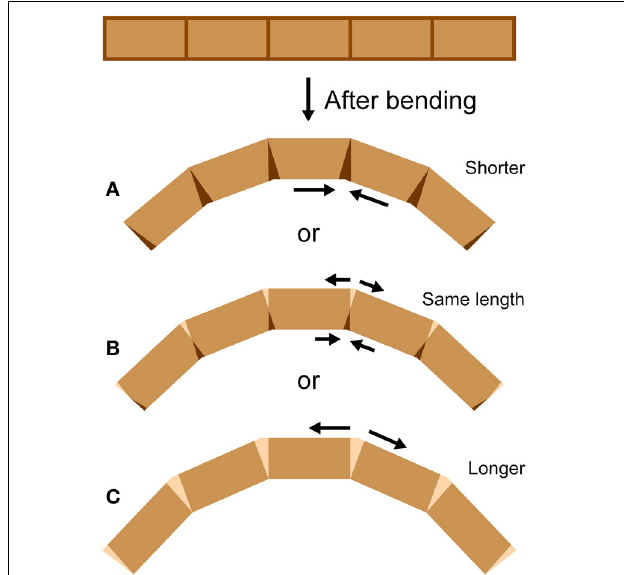
FIGURE 2 | Bending at joints. If a cylindrical structure only bends at joints, it can (A) shorten, (B) stay the same length, or (C) lengthen during bending, depending on the mechanical behavior of the joints (length measured along the central midline). At the joints, darkened areas indicate shortening (such as by cuticle folding or compressing) and lighter areas indicate lengthening (such as by cuticle unfolding or stretching).